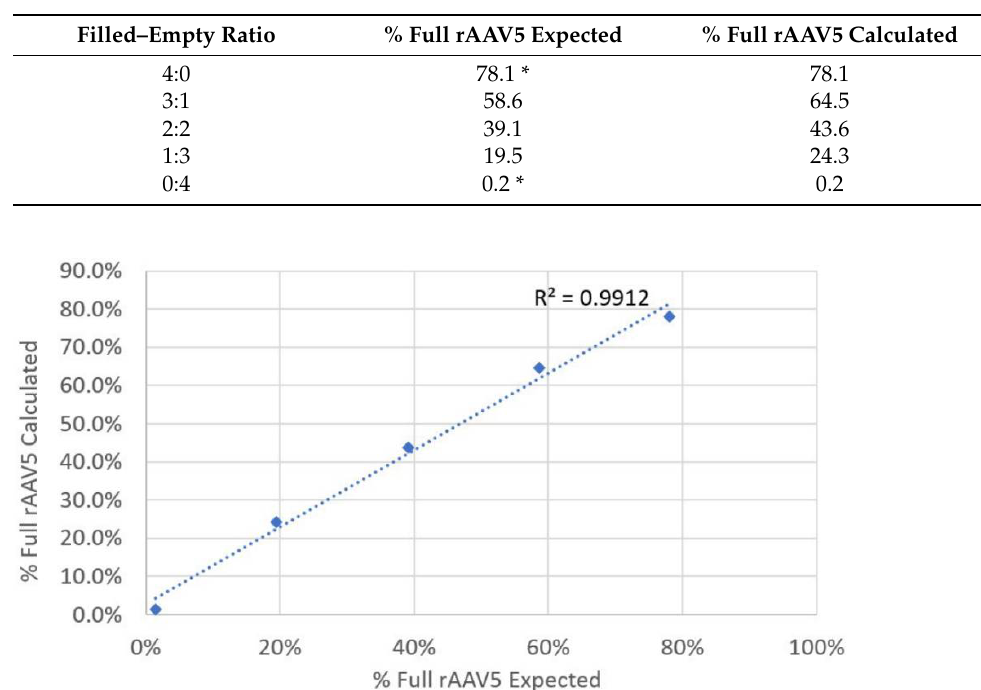
Figure 4. A plot of the expected and calculated percentage of full rAAV5 virus particles.